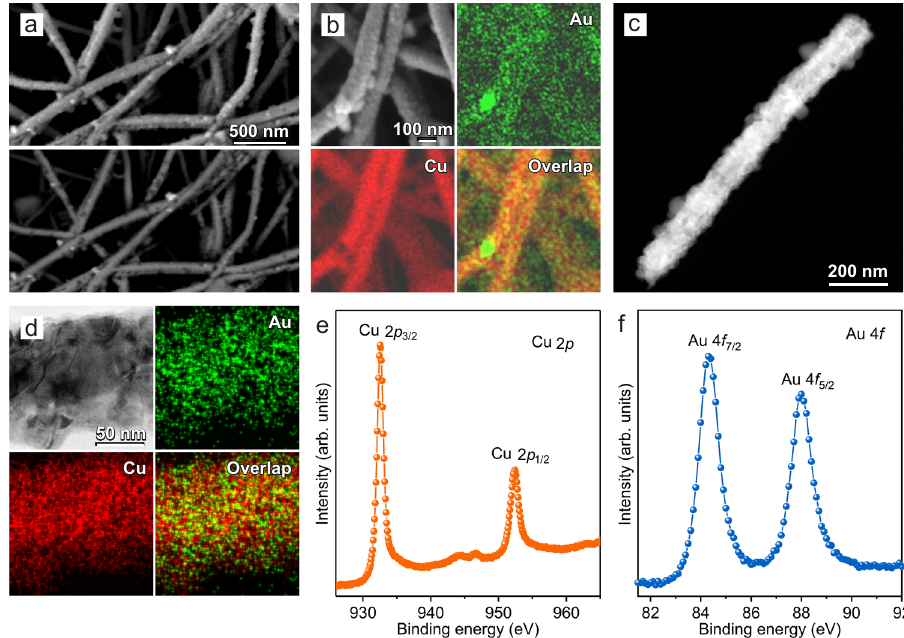
Fig. 2 Structural and compositional analyses of 7% Au – Cu catalysts on PTFE. a Low magni fi cation secondary electron image (above) and the corresponding backscattered electron image (below) of the 7% Au – Cu/PTFE, showing the dispersed Au nanoparticles (bright spots). b Secondary electron image and the corresponding EDX elemental mapping of Au and Cu for the 7% Au – Cu/PTFE. c High-angle annular dark- fi eld scanning